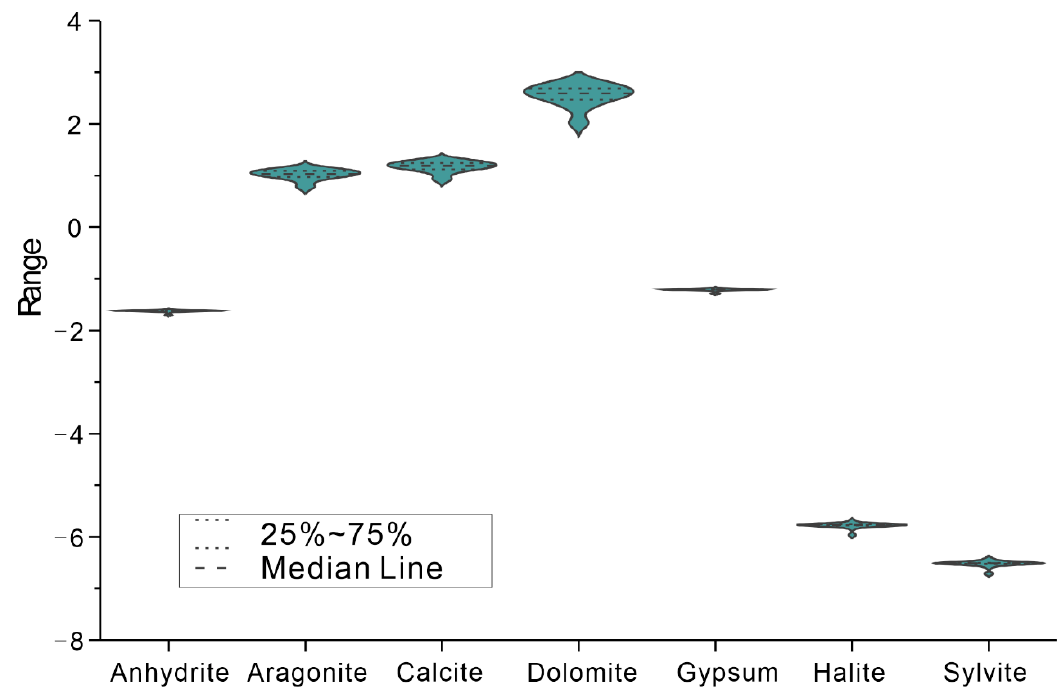
Figure 9. The results of the saturation index simulation of minerals in Bosten Lake.